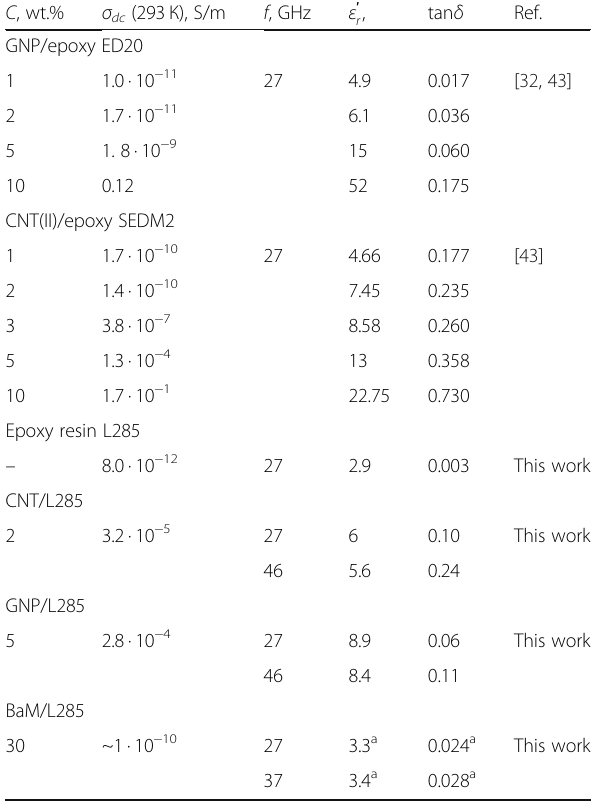
Table 2 Electrical conductivity σ dc , dielectric permittivity ε ′ r , and dielectric loss tangent tan δ for the epoxy CMs versus carbon fillers content C C ,